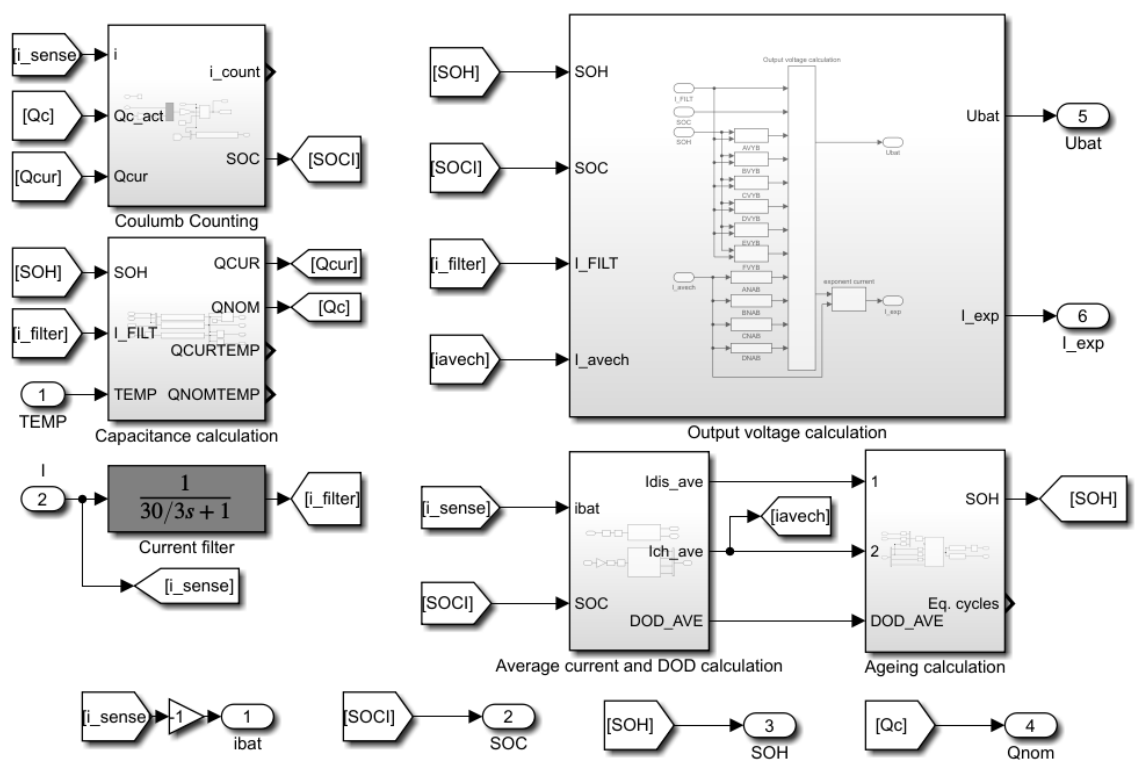
Figure 24. Interconnection of an individual block within the model.